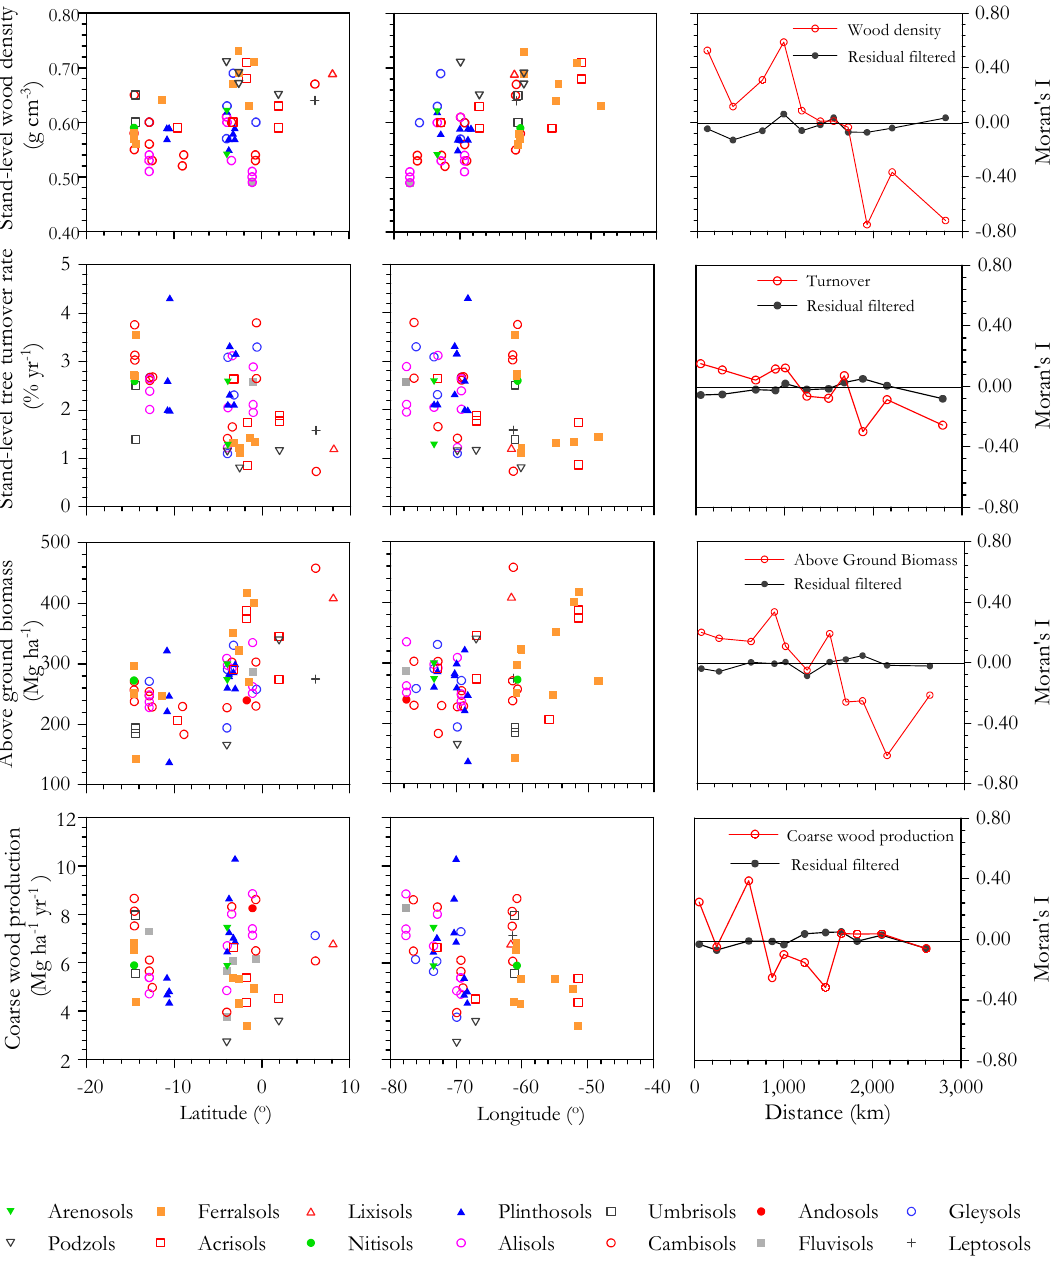
Fig. 2. Correlations of stand-level wood density, tree turnover, above-ground coarse wood production and above-ground biomass with the geographic space. Moran’s I correlograms are also given showing spatial autocorrelation but with spatial filters able to effectively remove its effect from regression